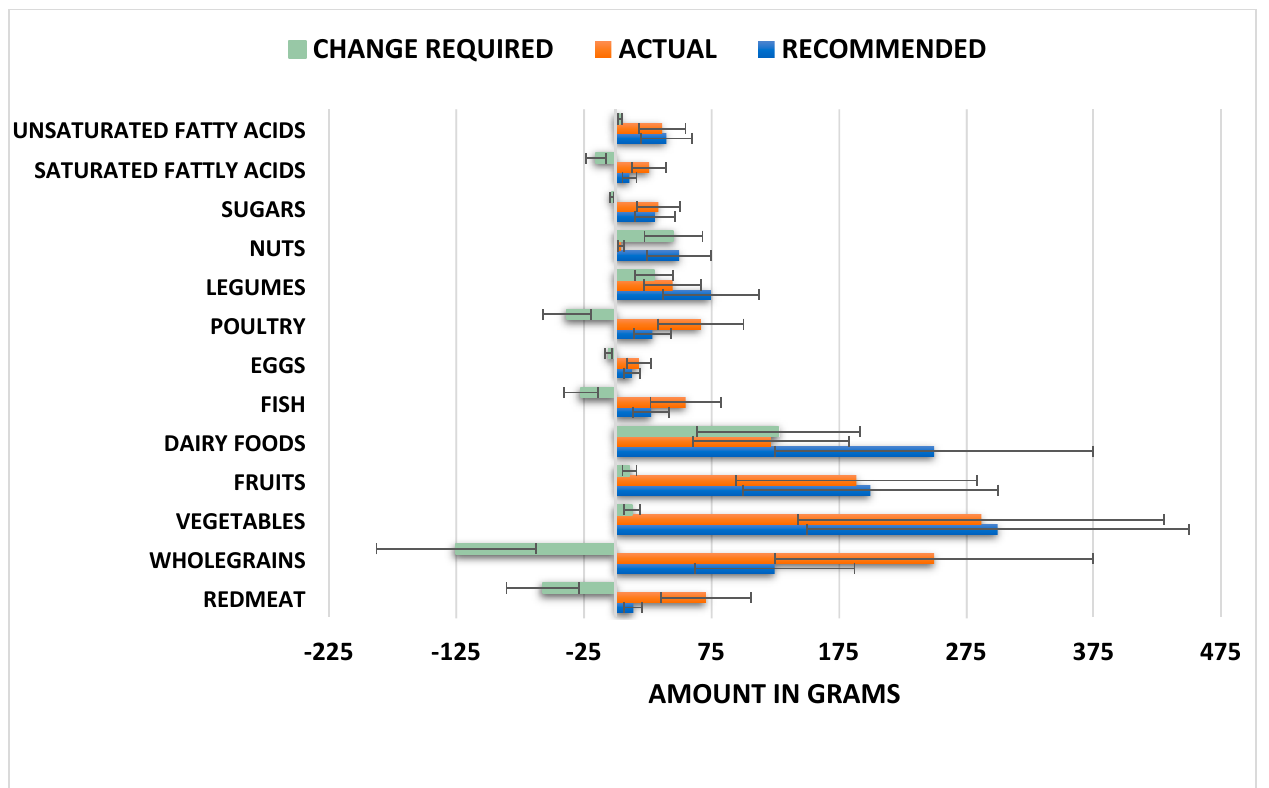
Figure 1. Diet gap between the actual intake and the recommended reference diet intake of food. When a range is recommended, average recommended intake is used. Data are mean (SEM).